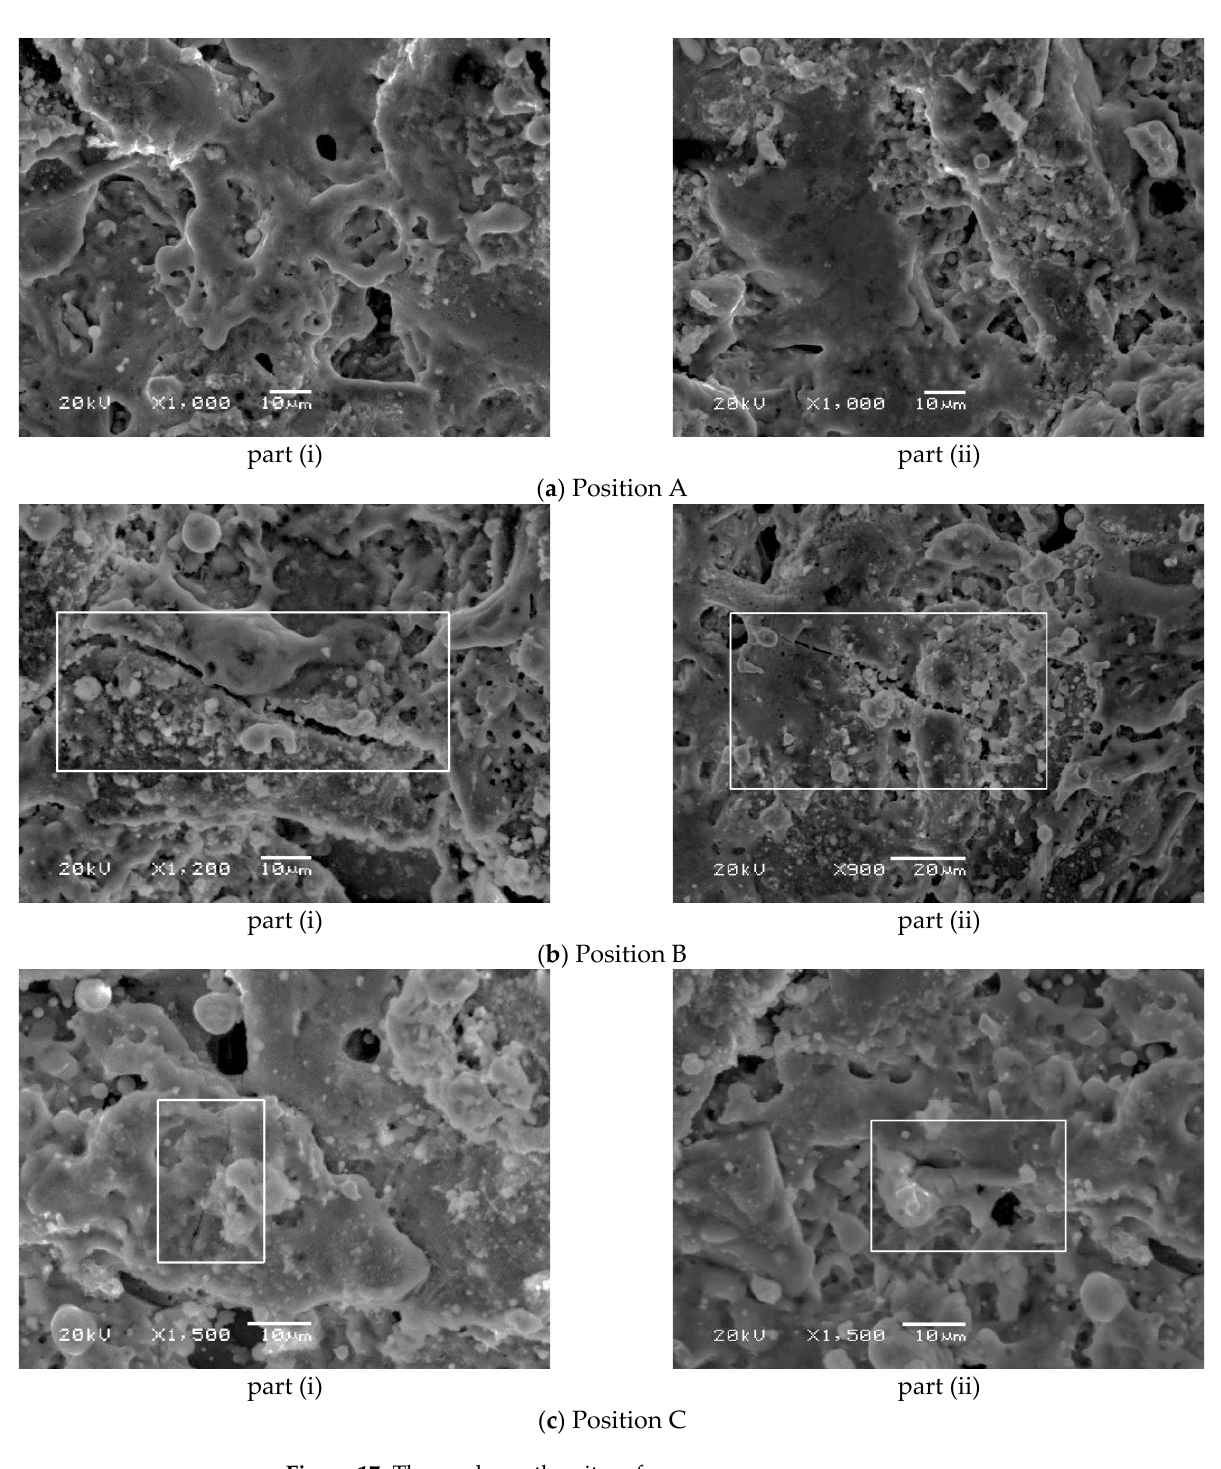
Figure 17. The cracks on the pit